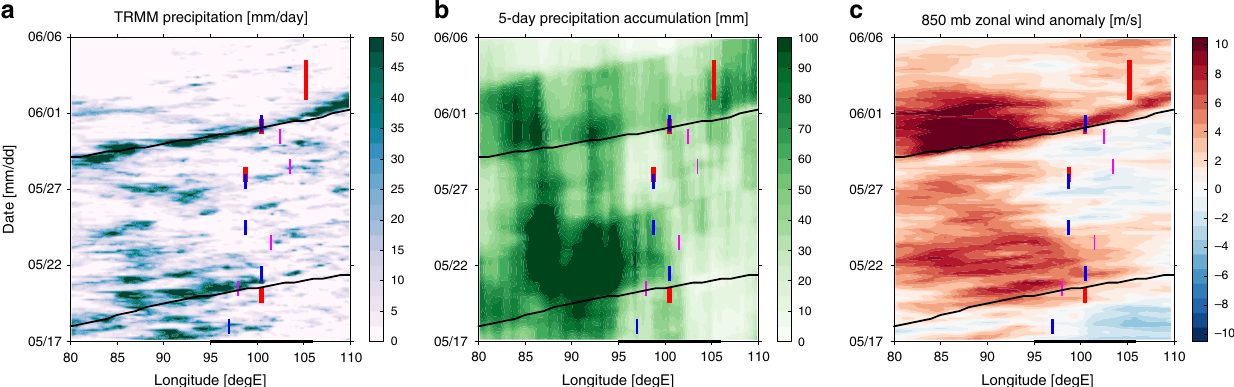
Fig. 4 Meteorological conditions during Padang fl ood period. Hovmoller diagrams of meteorological conditions for periods 17 May – 6 June 2017. a The 3- hourly precipitation rate [mm/day], ( b ) 5-day precipitation accumulation [mm] ( c ) 850 mb zonal wind anomaly [m/s]. All data are averaged in the 5S – 5N meridional band. Superimposed are convectively coupled Kelvin wave trajectories (black lines). Colored lines indicate fl oods identi fi ed using Twitter (red), Papers (blue) and Indonesian National Board for Disaster Management (magenta) databases. The position of Sumatra is marked with a black bar on the bottom of the panel.